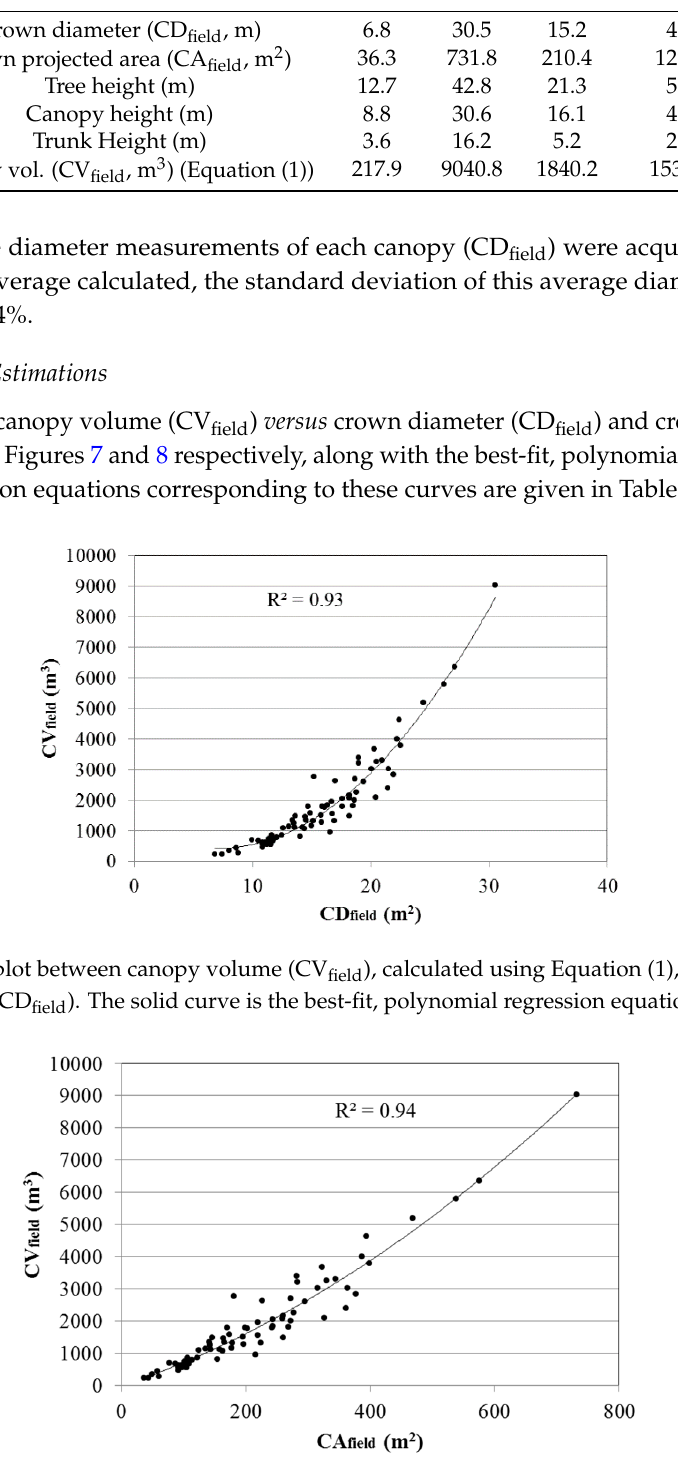
Table 2. Summary statistics for single trees from field measurements; n = 79 was the number of trees used in model development.